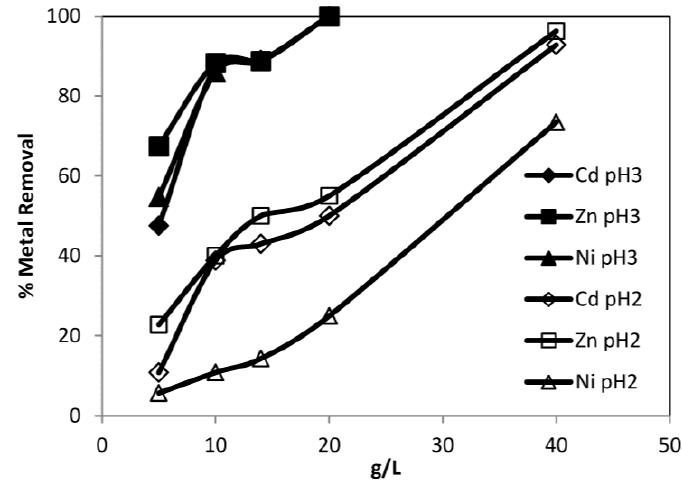
Figure 4. Effect of Bottom ash dosage on the removal of heavy metals.